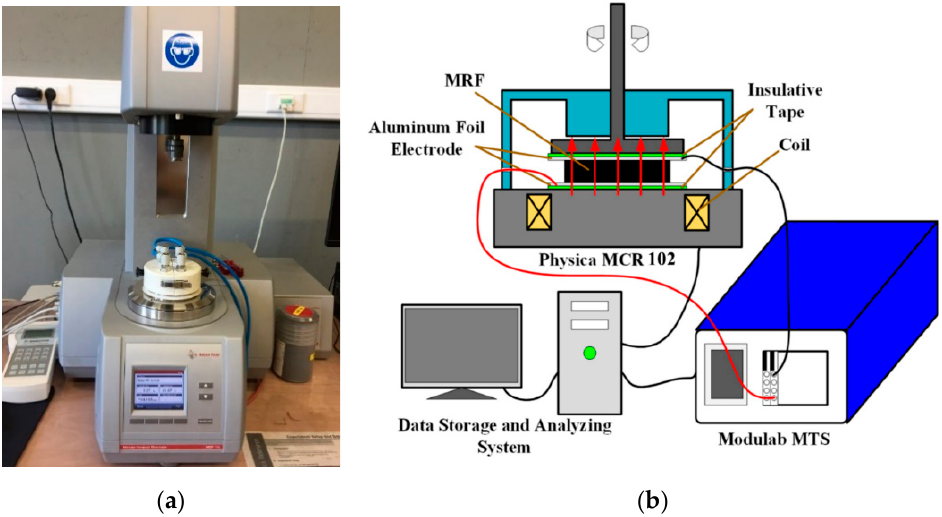
Figure 3. ( a ) MCR 102 rotational parallel plate rheometer equipped with a magnetic cell and ( b ) the corresponding schematic diagram.